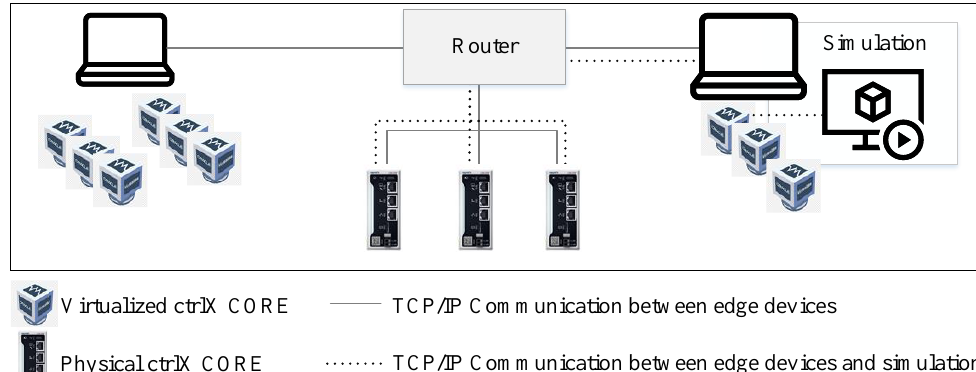
Figure 8. Experimental setup with a network of control units connected to a simulation